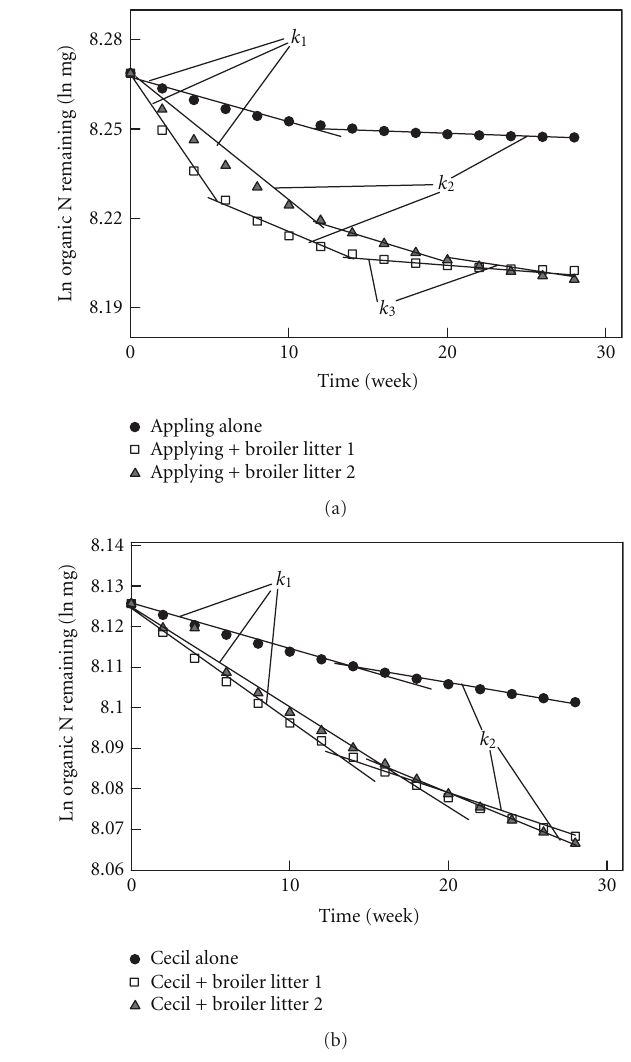
Figure 5: Cumulative organic nitrogen mineralized from Sucarnoochee soil (a) or Troup (b) soils amended with broiler litter 1 or 2 and incubated for 28 weeks under aerobic conditions.